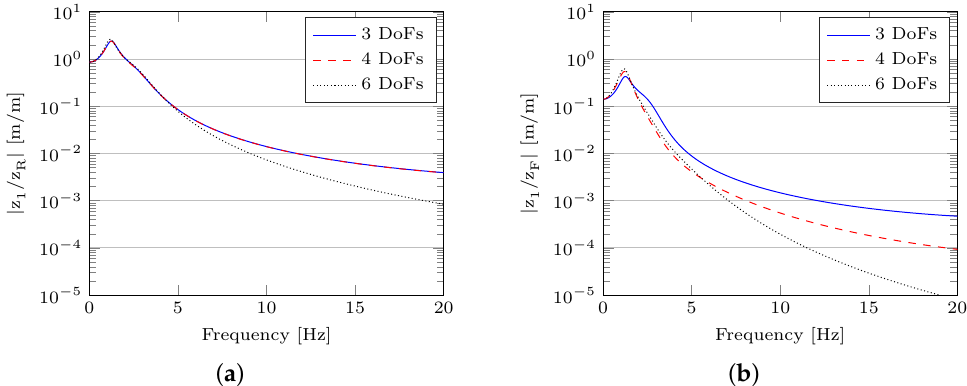
Figure 6. Transmissibility between the tractor wheels and the operator’s seat for different tractors: ( a ) rear wheel z 1 / z R ; ( b ) front wheel z 1 / z F